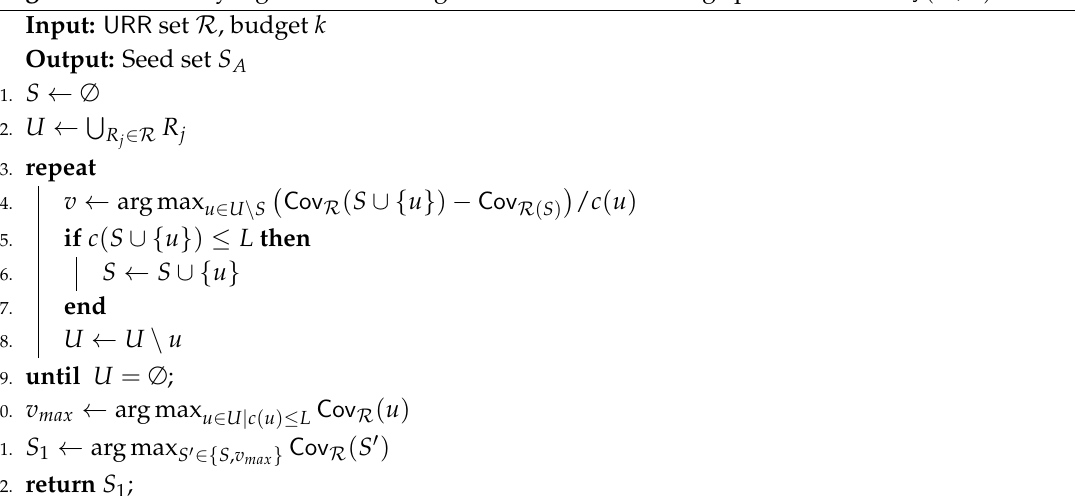
Algorithm 5: Greedy algorithm for Budgeted Maximum Coverage problem— Greedy ( R , L )